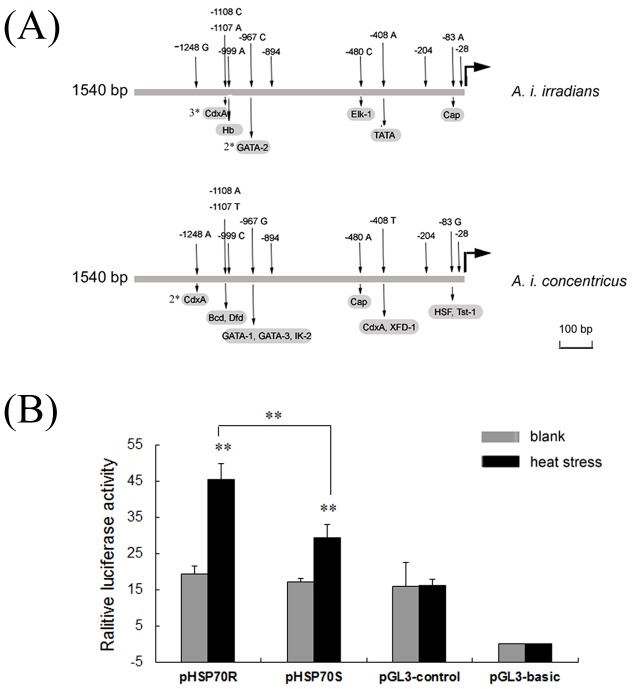
Dual luciferase report assay of AiHSP70 promoter with different haplotypes.(A) The dominant alleles and their corresponding putative binding sites for transcription factors in the HSP70 promoter-reporter constructs of A. i. irradians and A. i. concentricus. The Arabic numerals before the name of transcription factors indicate their amount; the black bent arrows mark the positions of the start codon, ATG, and the direction of transcription. (B) Relative luciferase activity (RLA) of Firefly and Renilla luciferase driven by AiHSP70 promoter. Two constructs containing the AiHSP70 promoter with thermosensitive haplotype (pHSP70S) and thermoresistant haplotype (pHSP70R) were solely transfected into Hela cells while the pGL3-basic transfected cells served as negative control (pGL3-basic) and the pGL3-control transfected cells served as positive control (pGL3-control). The pRL-TK Renilla luciferase vector was used as an internal control, and RLA of Firefly and Renilla luciferase was calculated. Vertical bars represent the mean ± S.E. (N = 6). (**: P<0.01).